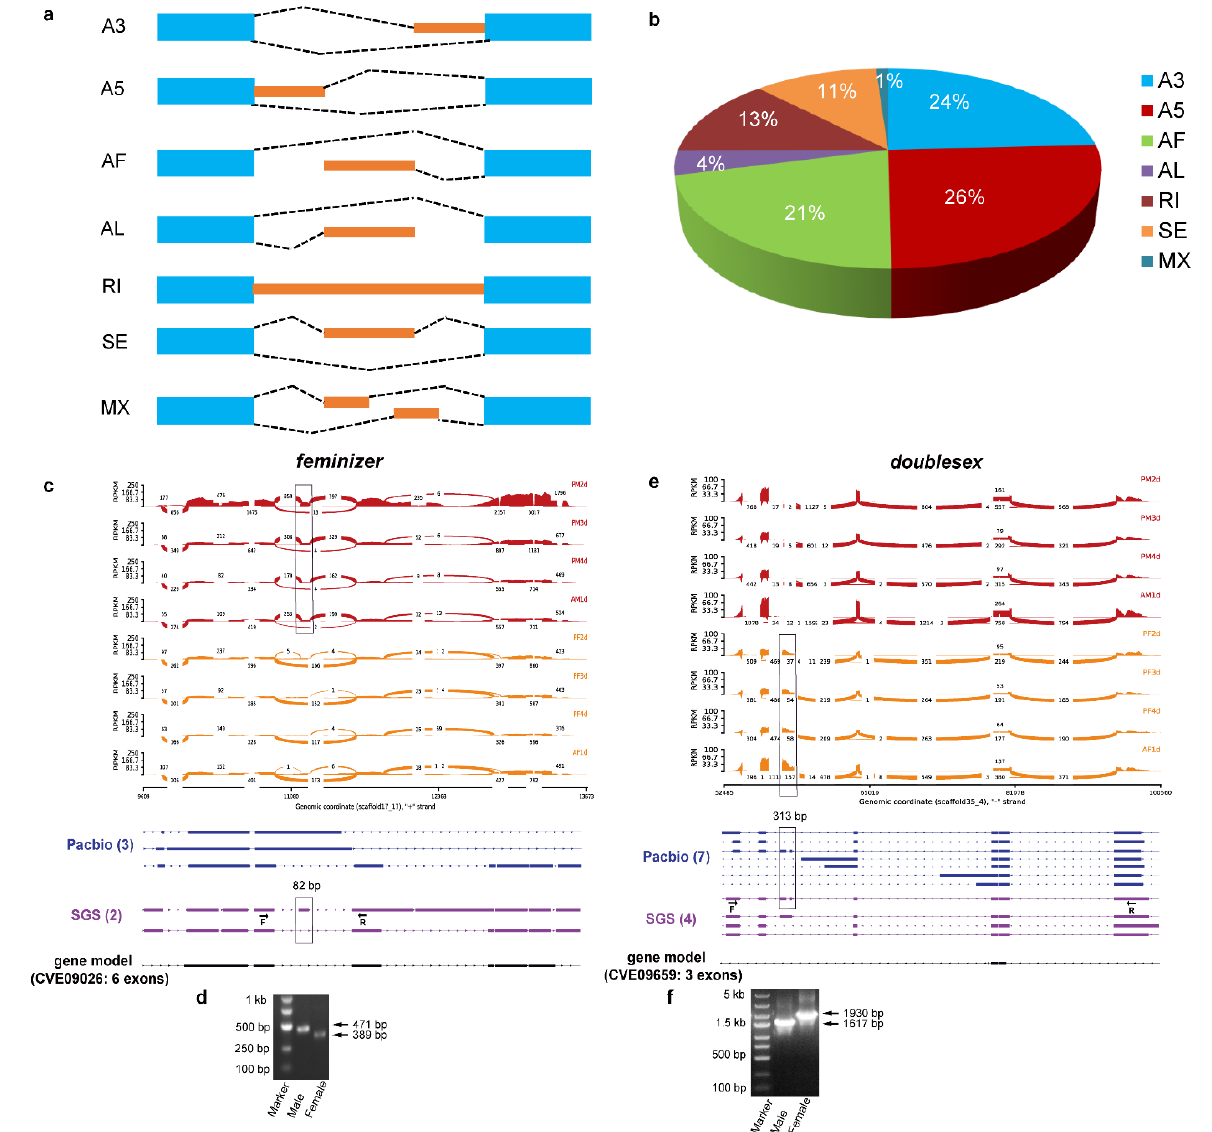
Figure 4. Alternative splicing events analysis in C. vestalis . ( a ) Seven types of AS events were identified in C. vestalis . ( b ) The proportions of different alternative splicing types identified in C. vestalis by combining PacBio and SGS data. ( c ) Sashimi plot of alternative isoforms of feminizer in C. vestalis . ( d ) A male-specific exon in the feminizer gene was verified by RT-PCR. ( e ) Sashimi plot of alternative isoforms of dsx in C. vestalis . ( f ) Two female-specific exons in dsx verified by RT-PCR. The thickness of the curves in red and orange crossing two splicing junction sites (SJ) represents the coverage degree of Illumina RNA-Seq reads, and the number of junction reads is marked in the middle of the splicing site. The RNA coverage is given as the log-transformed reads per kilobase of transcript per million mapped reads (RPKM) value. Blocks represent exons, and lines represent introns. The black rectangular box indicates sex-biased exons selected for RT-PCR verification. Forward and reverse primers used in RT-PCR were marked as F and R, respectively. SGS, second-generation sequencing.